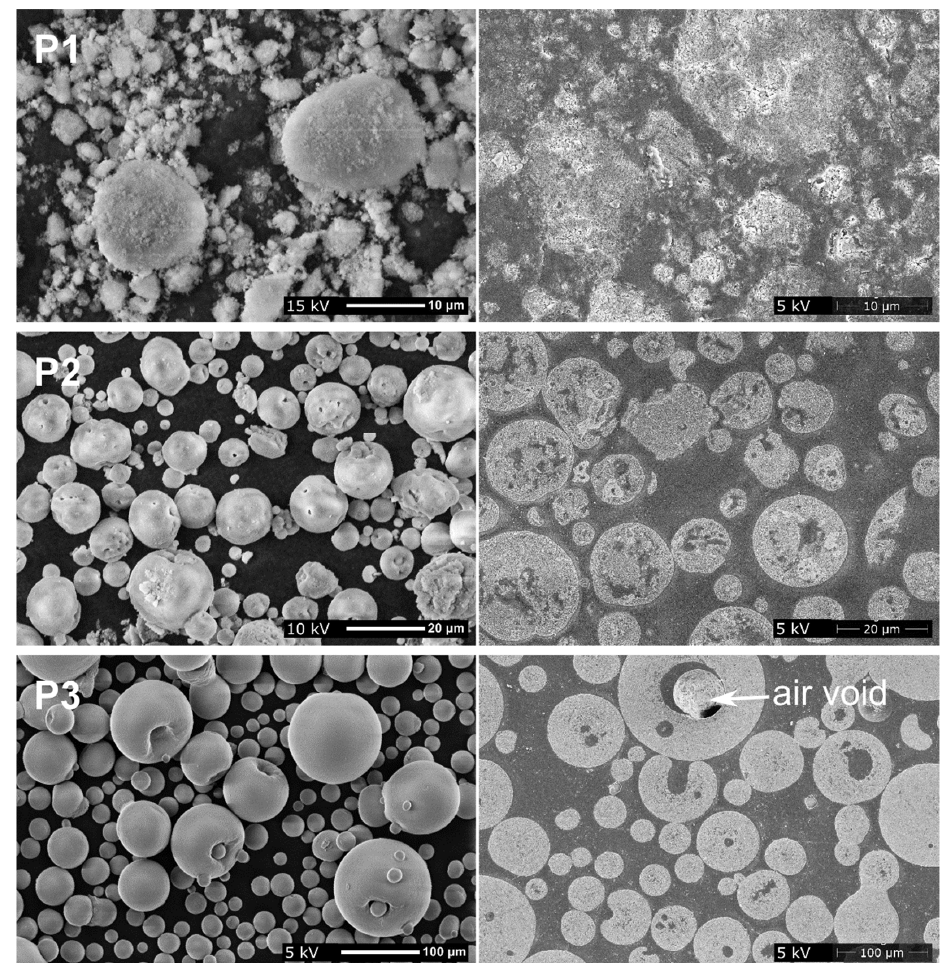
Figure 2. Particle morphologies of the raw powder P1 and the spray-dried powders P2 and P3 in SEM (SE detector). Left side: collected particles. Right side: Prepared cross-sections from embedded particles show their internal structure.